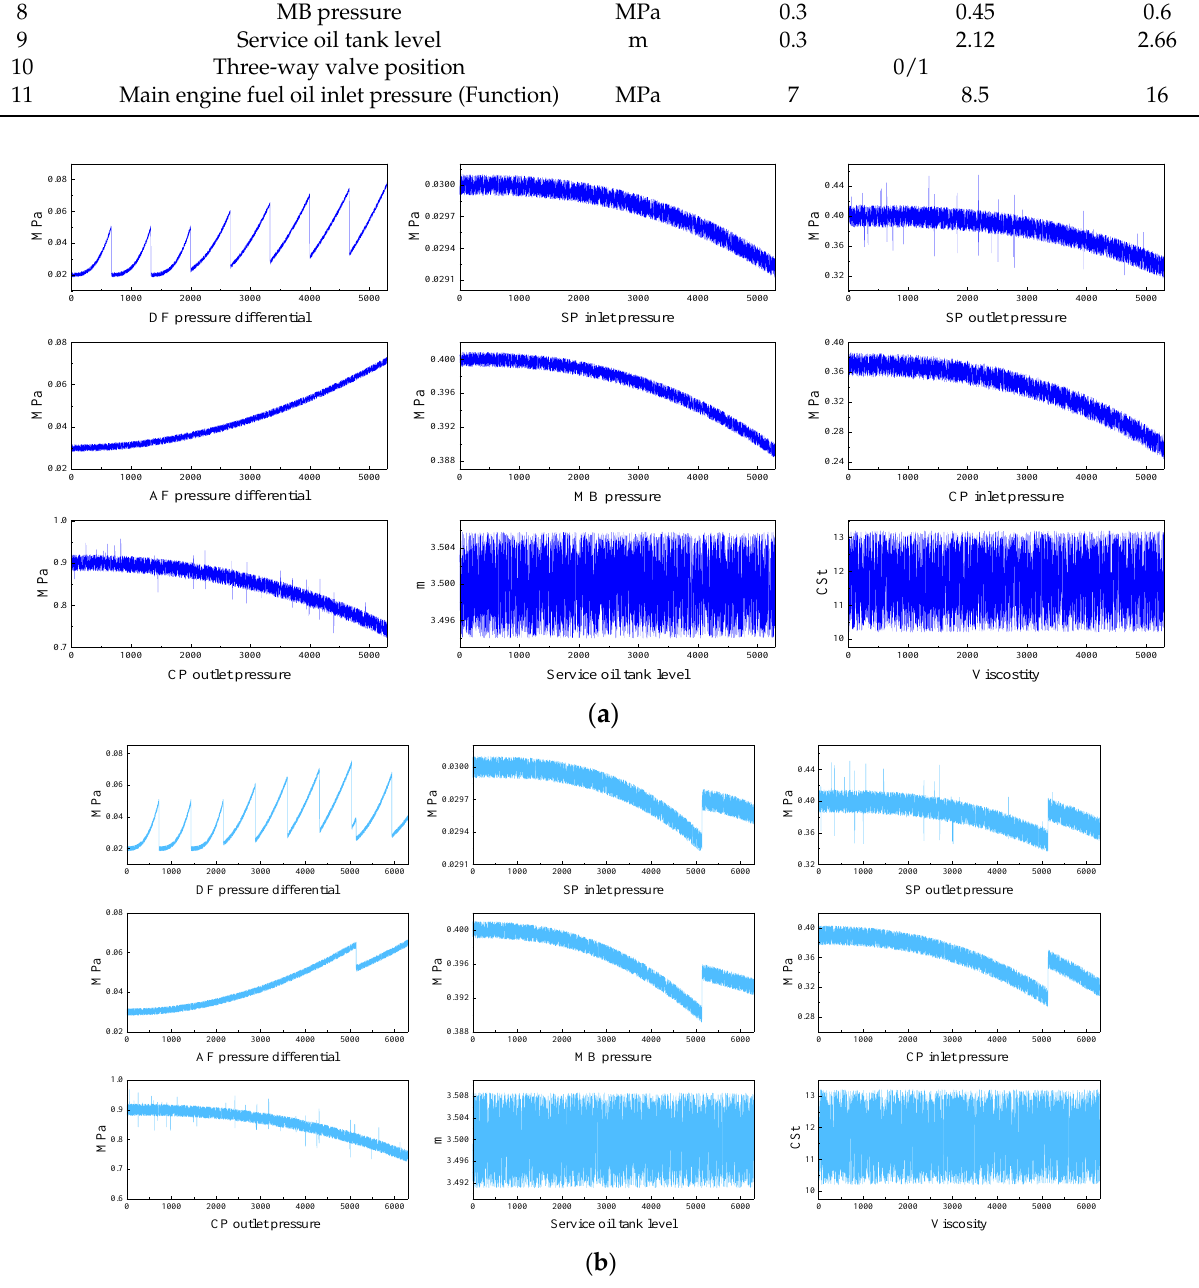
Figure 6. Illustration of raw signals from two datasets: ( a ) Dataset A; ( b ) Dataset B.